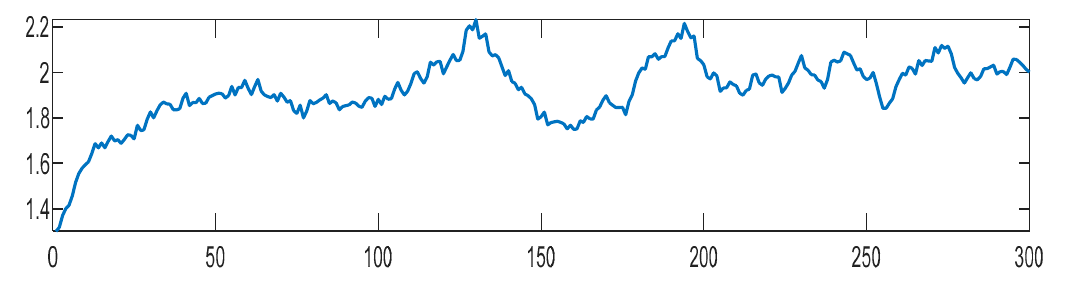
Figure 18. Decision − making for project 4. Figure 18. Decision-making for project 4.